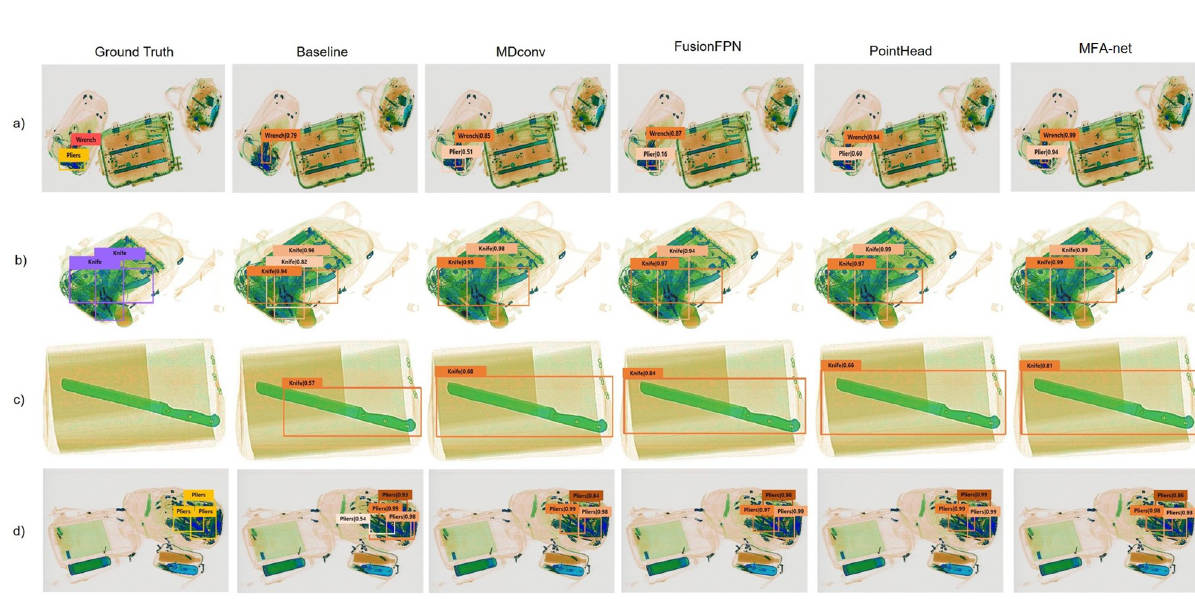
Fig 8. Visualization of the effect of the proposed MDConv, FusionFPN, point head, and MFA-net with all the proposed modules on SIXray [2].